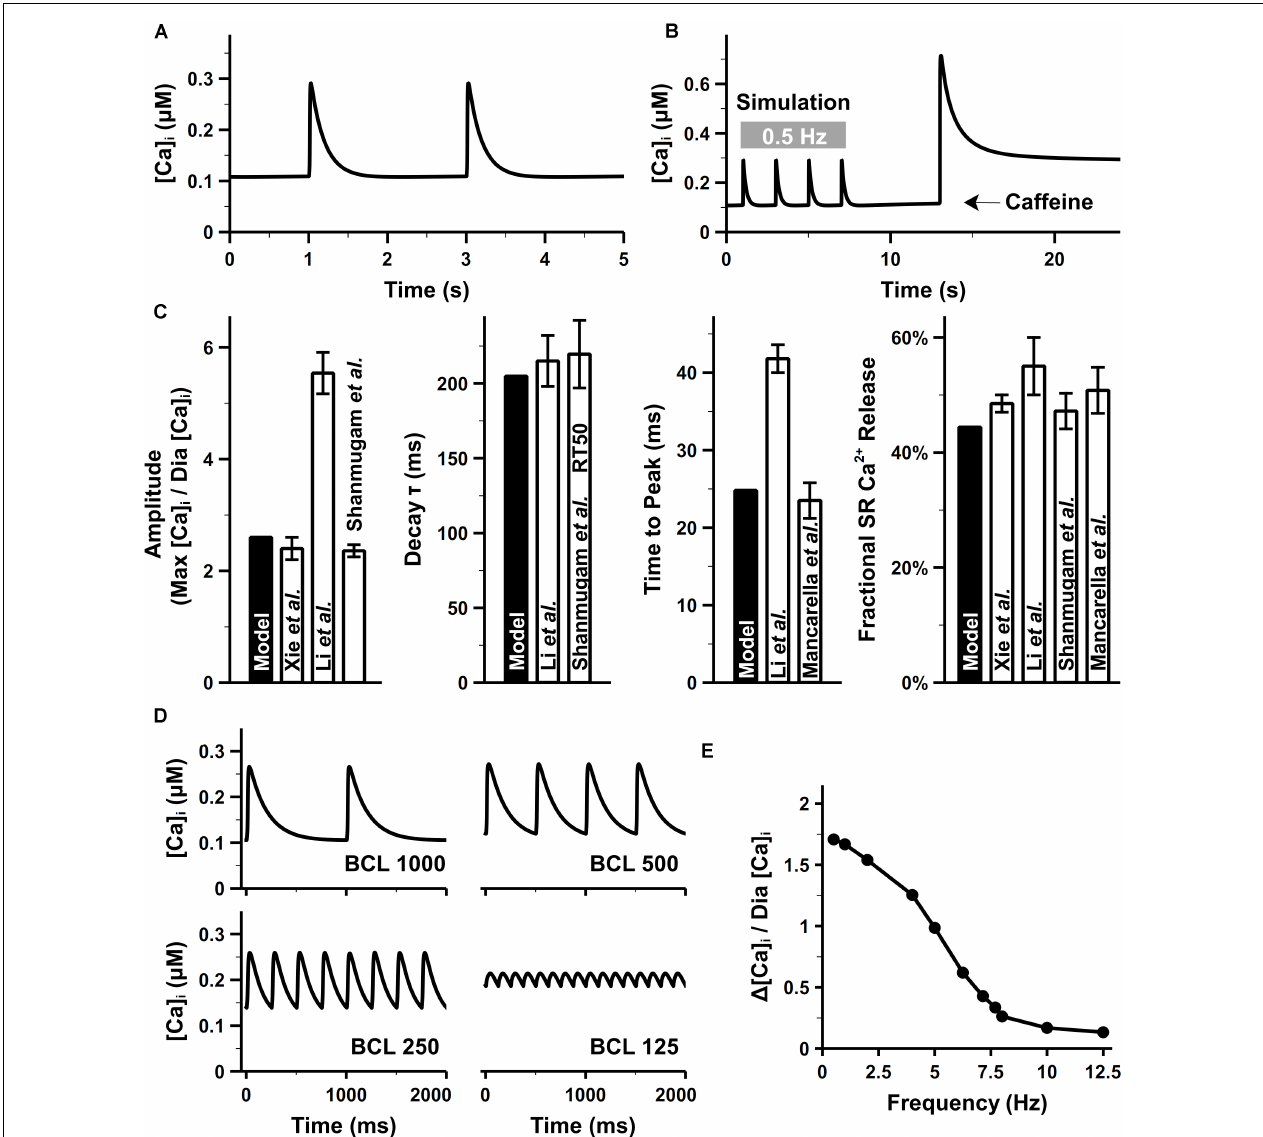
FIGURE 9 | Atrial intracellular Ca 2 + transient from simulation and experiments. (A) CaT under the pacing rate of 0.5 Hz. (B) Simulated caffeine-induced CaTs. (C) [Ca] i amplitude, time to the peak of [Ca] i , time constant for the decay phase of [Ca] i , and fractional Ca 2 + release, calculated at 0.5 Hz. (D) Time course of CaTs under 1-, 2-, and 4-, and 8-Hz pacing rate. (E) Amplitude of CaTs at various pacing rates. The diastolic Ca 2 + concentration (Dia [Ca] i ) was fixed as the value when the cell was paced at 0.5 Hz [experimental data: Xie et al. (2012) at body temperature, Li et al. (2005); Mancarella et al. (2008), Escobar et al. (2004); Walden et al. (2009), and Shanmugam et al.